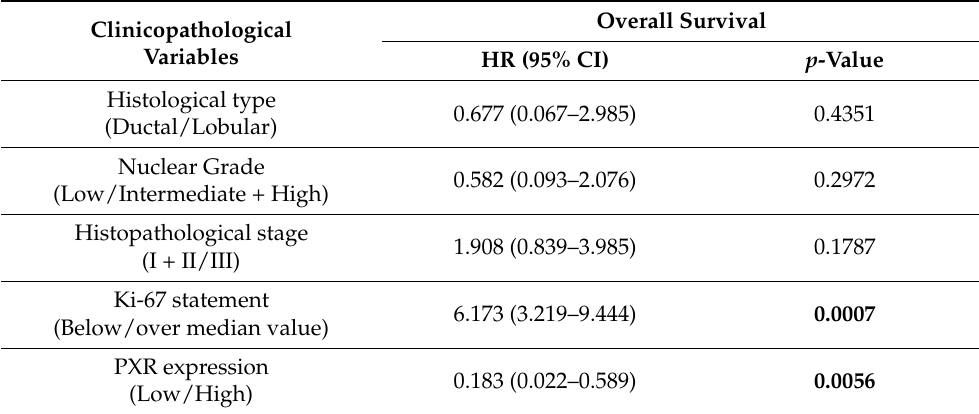
Figure 2. Kaplan–Meier survival analysis stratified according to PXR expression in 148 breast carcinoma patients for: ( A ) Overall patients’ survival and ( B ). Disease-free patients’ survival. Complete: When the patient completed the follow-up Censored: When the patient, for any reason, did not complete the follow-up. According to the immunoblotting results, all cell lines that were used show PXR Table 2. Multivariate analysis for nuclear grade, histopathological stage, Ki-67 statement, and PXR expression in comparison with the control cell line. Higher expression was observed in expression for overall and disease-free patients’ survival. Statistically significant values are shown T47D and MDA MB 231 cell lines. (Figure 3). in